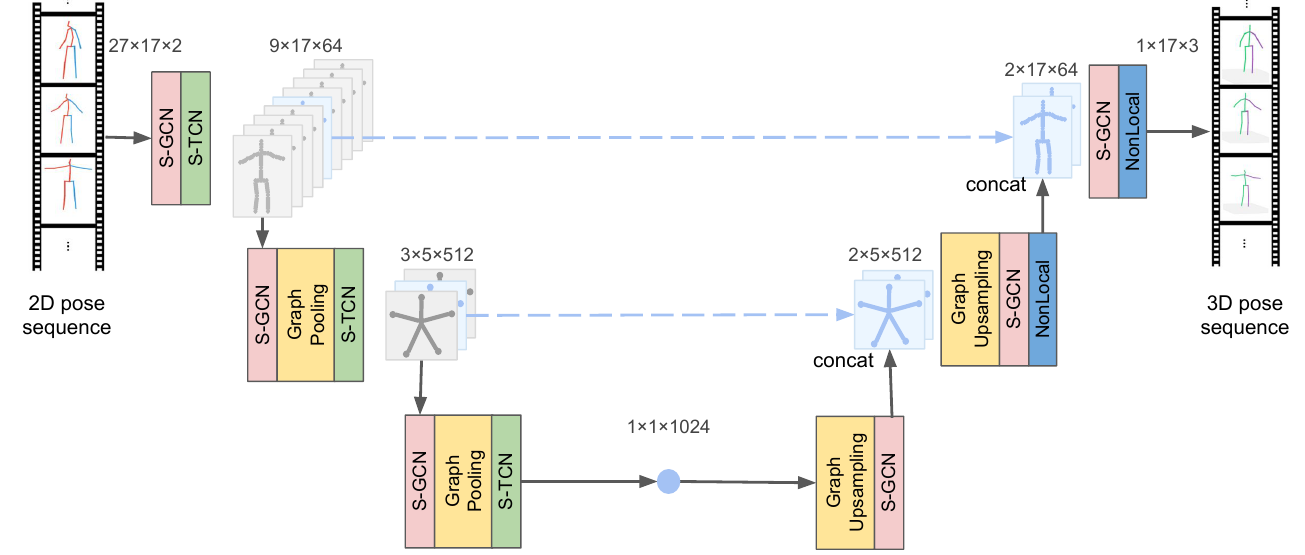
Figure 2. Overview of the proposed spatio-temporal U-Net scheme. The STUNet architecture consists of a cascade structure of semantic-structural graph convolution network(S-GCN) layers and structural temporal convolution network (S-TCN) layers to progressively integrate semantic features in local time and space. Taking 27 frames of input as an example, the model contains two layers of graph pooling in the spatial dimension and three layers of TCN compression in the temporal